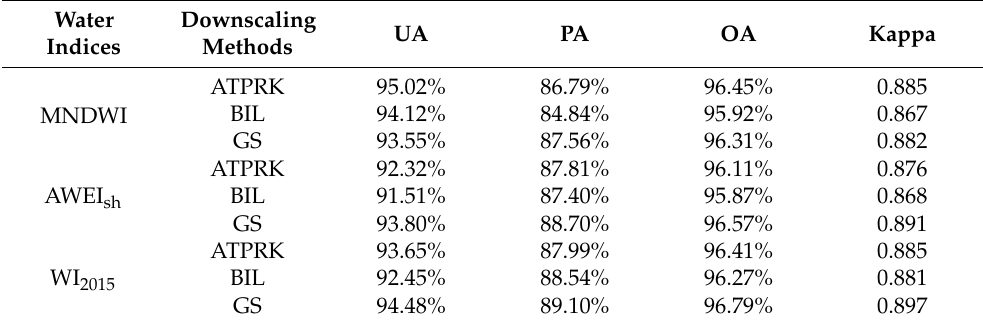
Table 1. Quantitative evaluation of water body extraction results in different downscaling methods and water indices